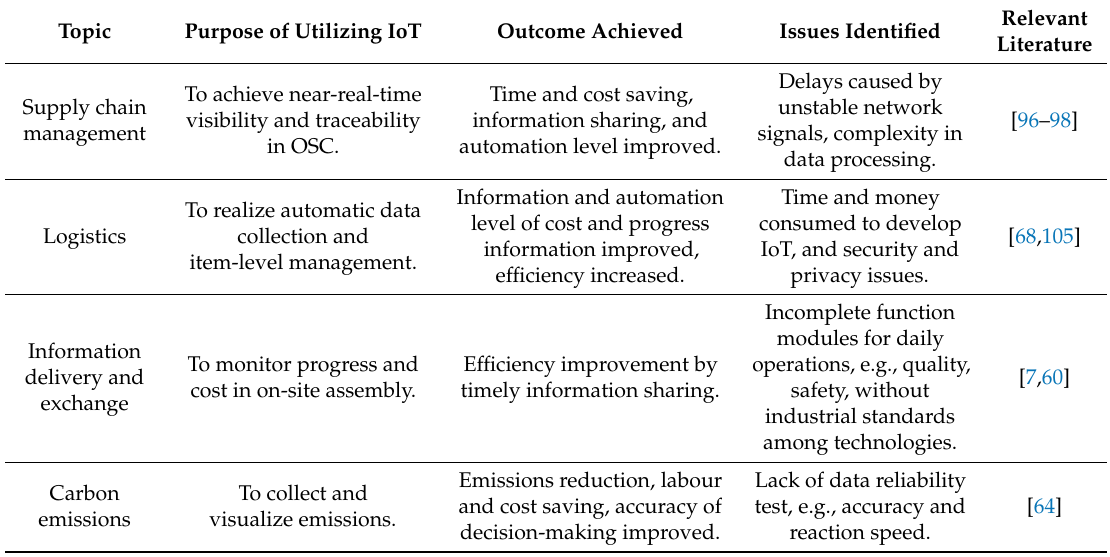
Table 7. Research topics, purpose of the Internet of Things (IoT) adoption, and outcomes achieved in previous